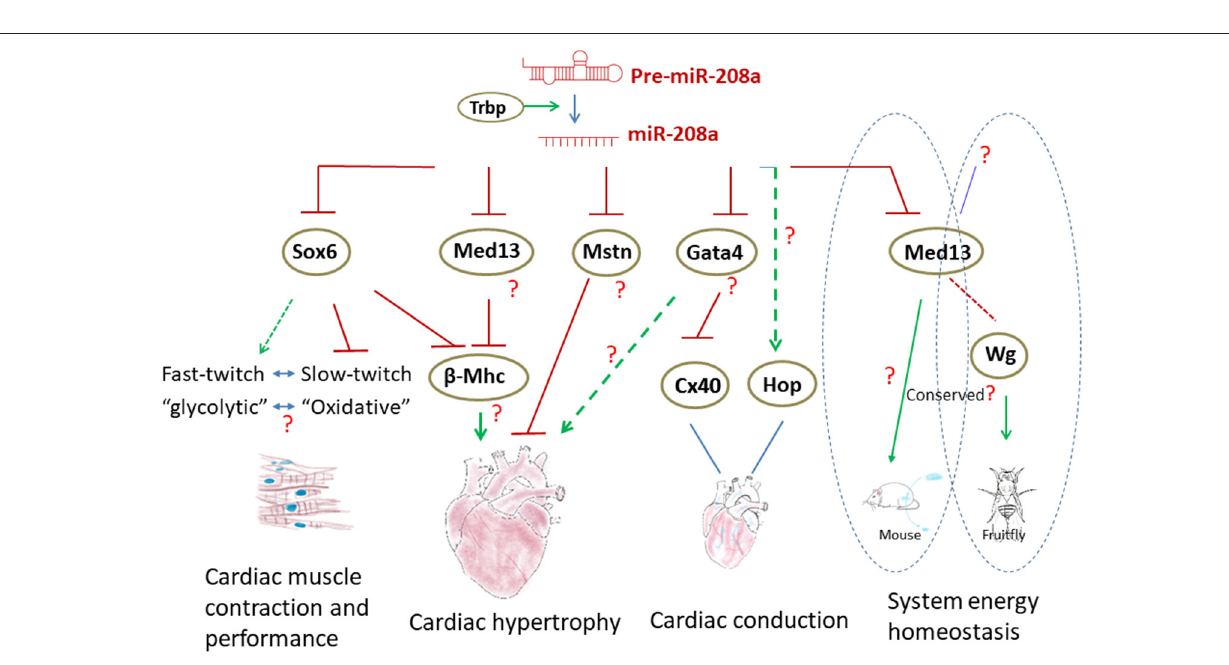
FIGURE 3 | The regulatory networks involving miR-208a in the heart. Normal biogenesis of miR-208a in the heart requires TRBP. miR-208a regulates cardiac function by modulating the expression of downstream genes. In addition, miR-208a in the heart can also control the system energy homeostasis through MED13. Wg was found to be a downstream factor of MED13 in Drosophila to regulate metabolism, yet it is not clear if the processes are conserved in